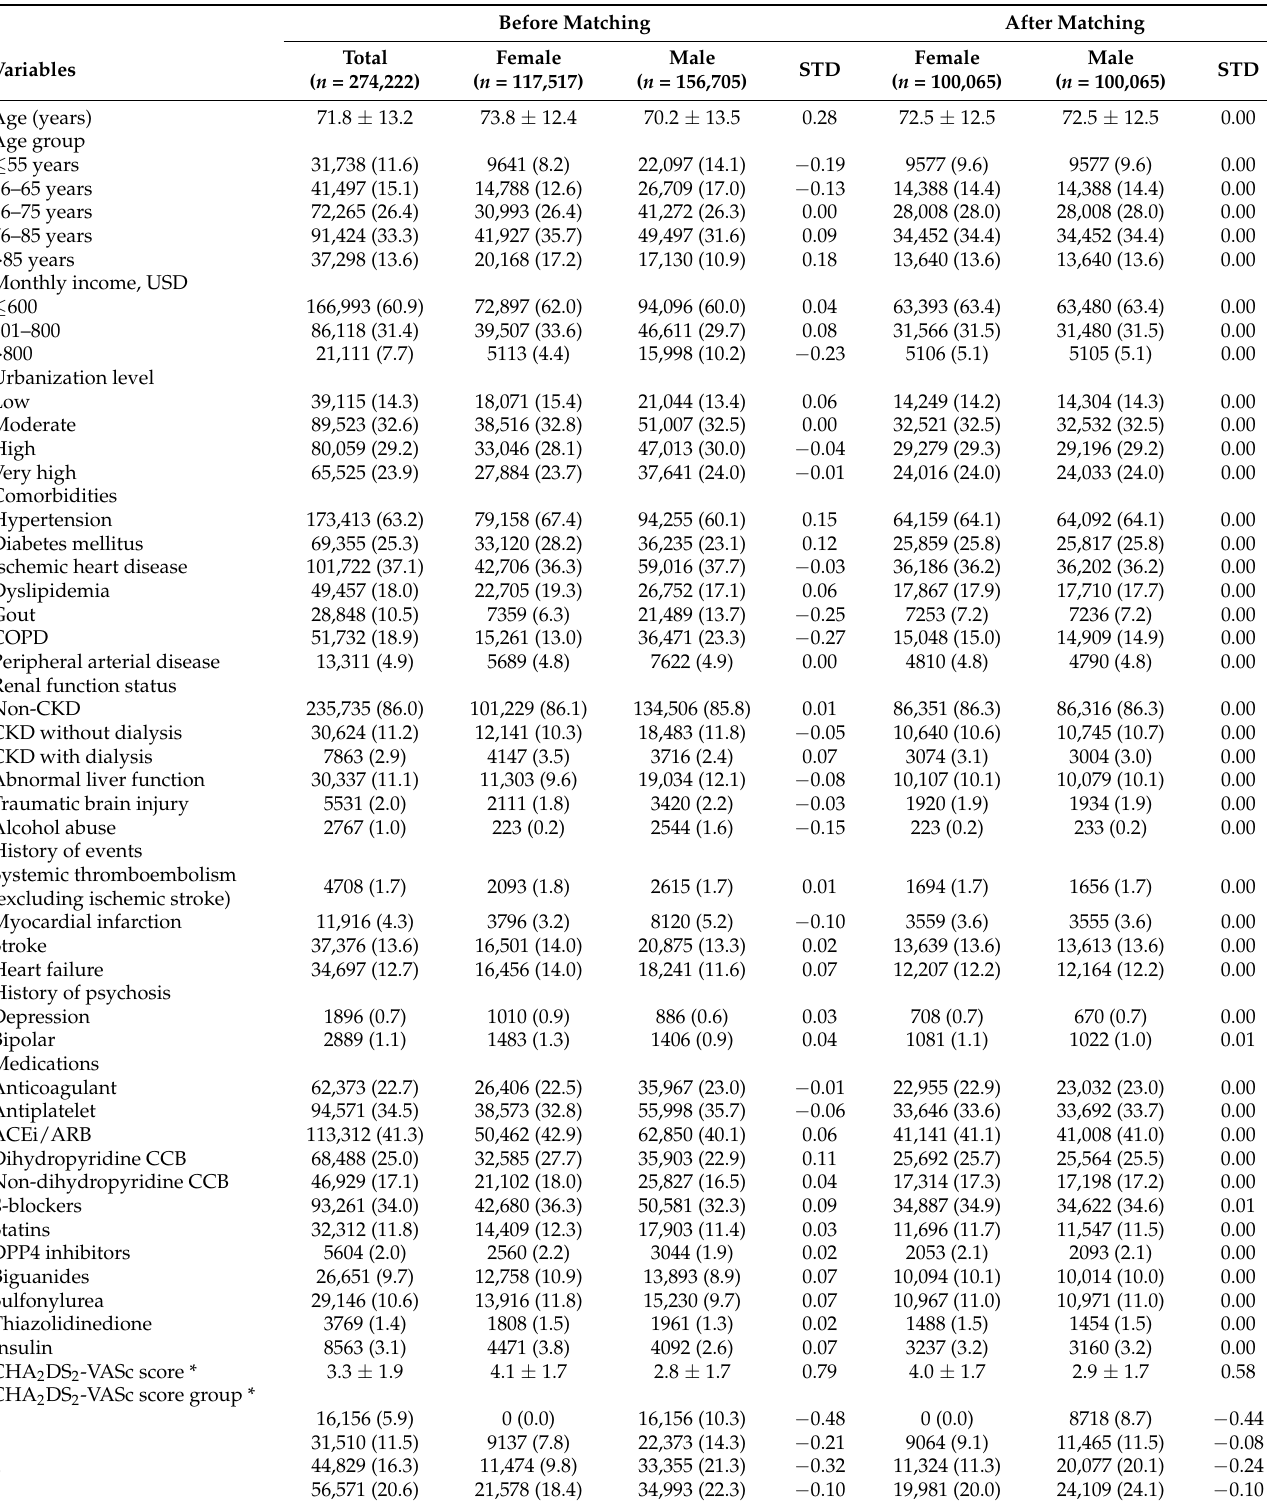
Table 2. Baseline characteristics of the study patients before and after propensity score